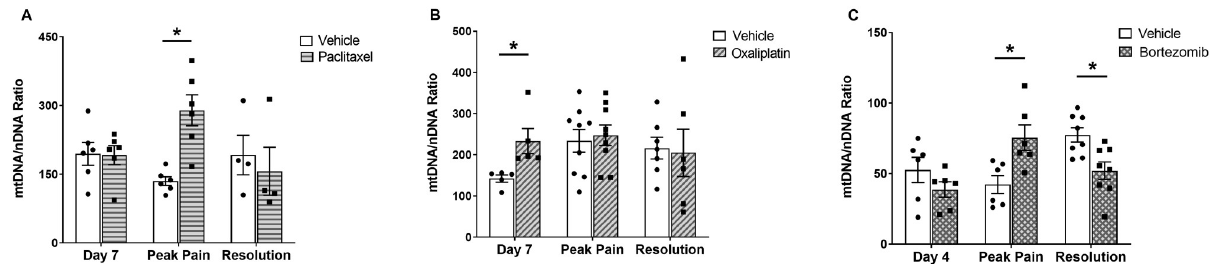
Fig 2. MtDNA levels in whole blood following chemotherapy administration. MtDNA levels are quantified as mtDNA:nDNA ratio. (A) MtDNA levels in animals administered with four injections of 2 mg/kg paclitaxel or an equal volume of vehicle solution. Day 7 and peak pain: n = 6 per group; resolution: n = 4 per group. (B) MtDNA levels in animals administered with four injections of 2 mg/kg oxaliplatin or an equal volume of vehicle solution. Day 7: n = 5 per group; peak pain: n = 9 per group; resolution: n = 6–7 per group. (C) MtDNA levels in animals administered with four injections of 0.2 mg/kg bortezomib or an equal volume of vehicle solution. Day 4 and peak pain: n = 6 per group; resolution: n = 8 per group. (pain: n = 9 per group; resolution: n = 6–7 per group. Data are expressed as mean ± SEM. � p < 0.05, unpaired two-tailed t -tests.